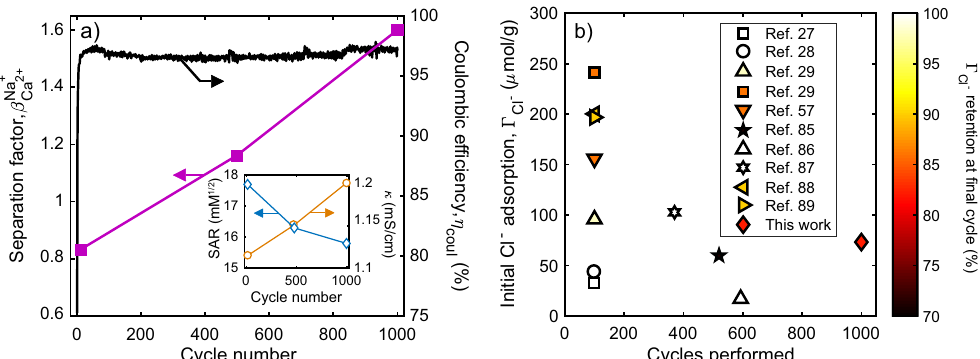
Fig. 7 Selectivity, output water quality, and cell stability in long-term cycling. a Measured water separation factor and Coulombic ef fi ciency for 1000-cycle experiment at 1.2 V and 6 min FCT, S – P cell. Inset: product water SAR and conductivity. b Comparison of Cl − adsorption capacity for long-term CDI cycling experiments in this and other works 27 – 29,57,85 – 89 . Marker position on the vertical axis indicates initial Cl − capacity, and color indicates the percentage of retained Cl − adsorption capacity at the fi nal